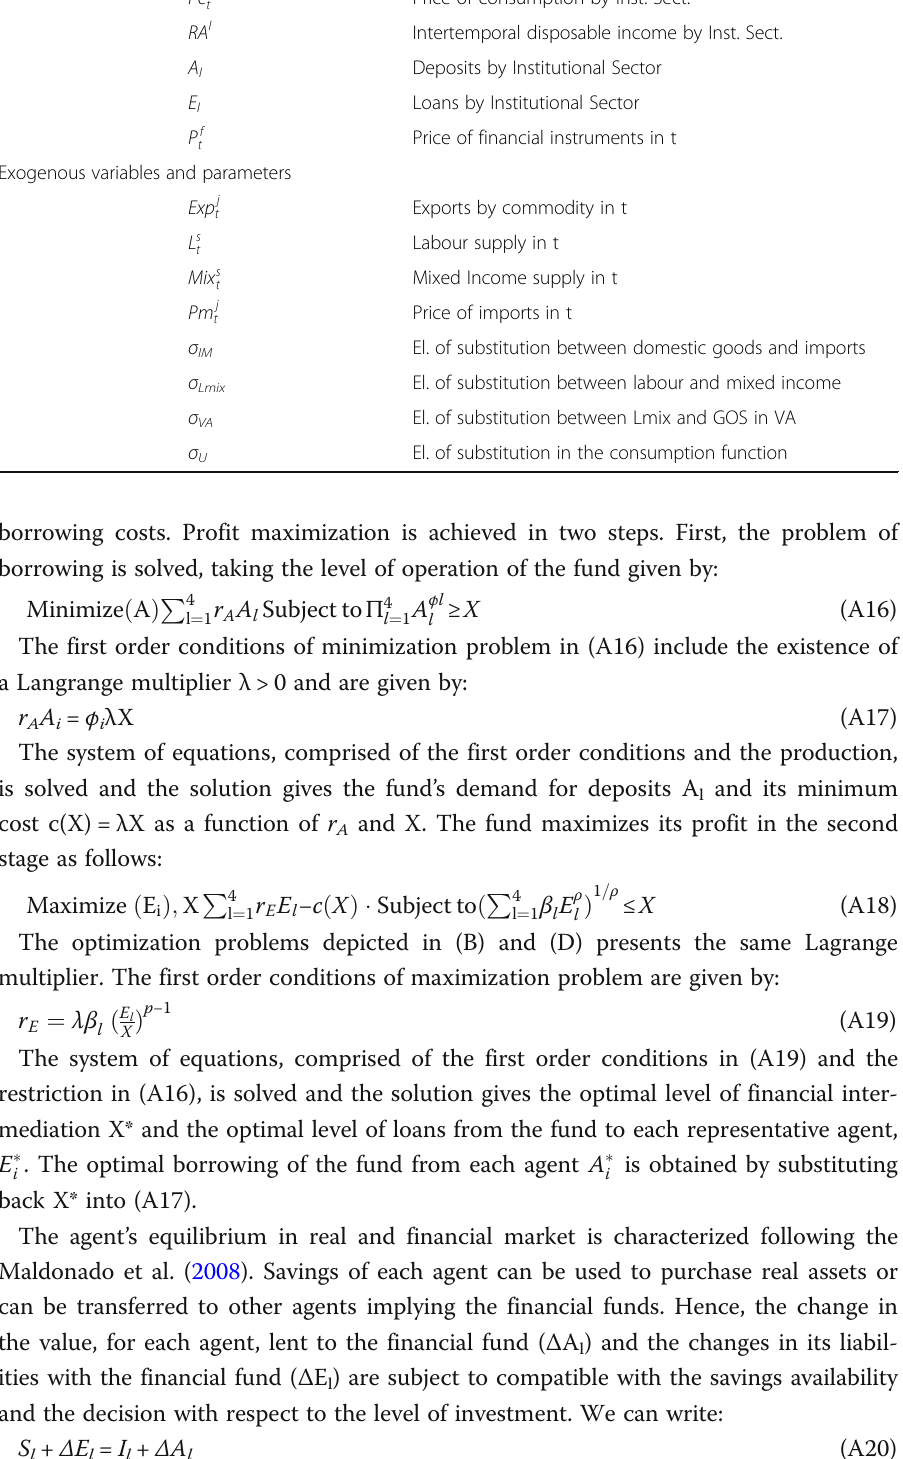
Table 5 List of parameters and variables (Continued) Pu l Intertemporal price of Utility by Inst.